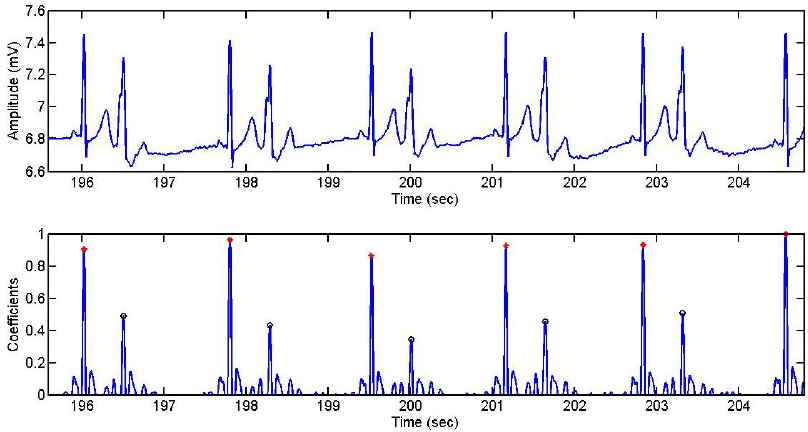
Figure 23. R wave and extrasystole detection.